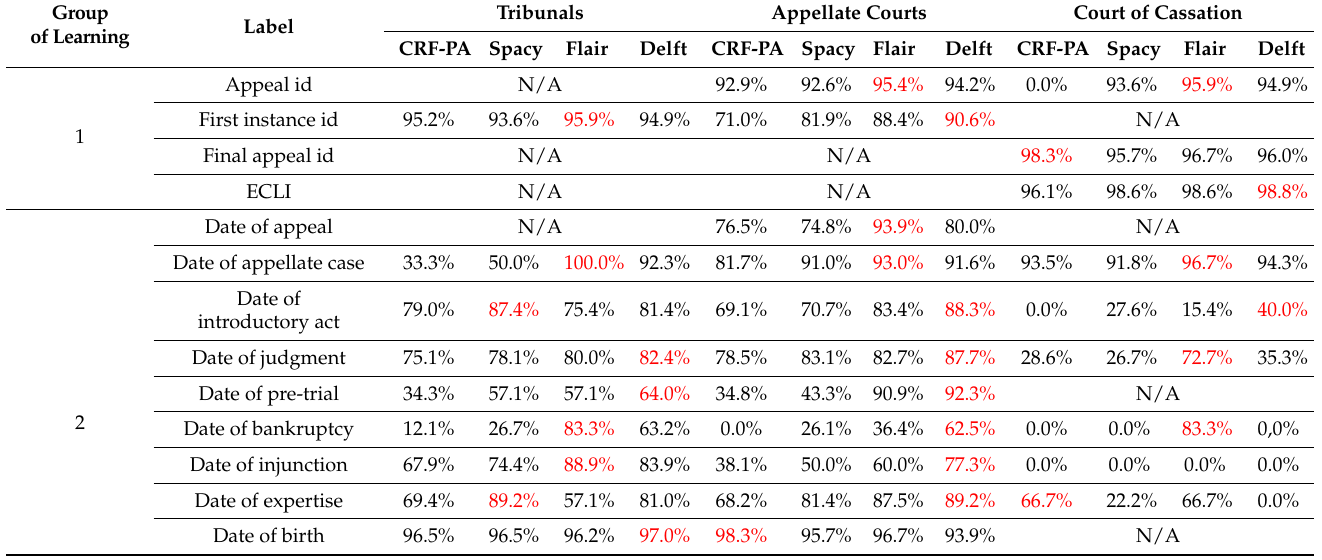
Table 9. Quality by type of label (first